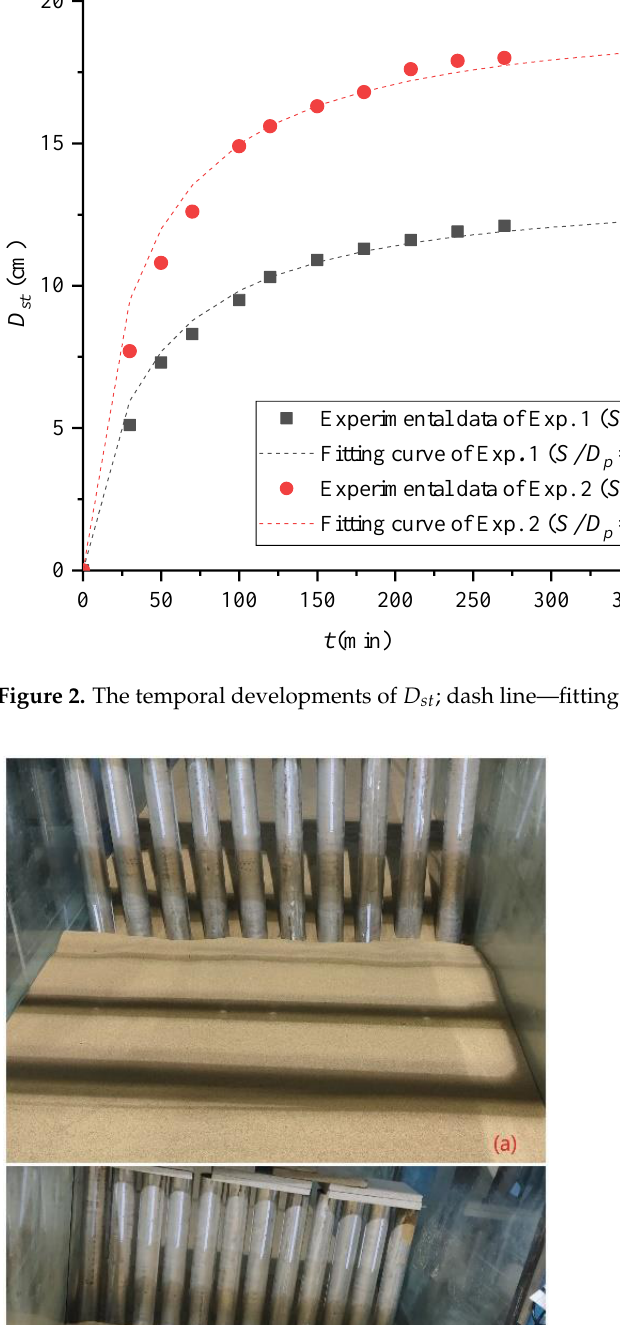
Figure 3. Photos of the experiments; ( a ) Exp. 1 and ( b ) Exp. 2.